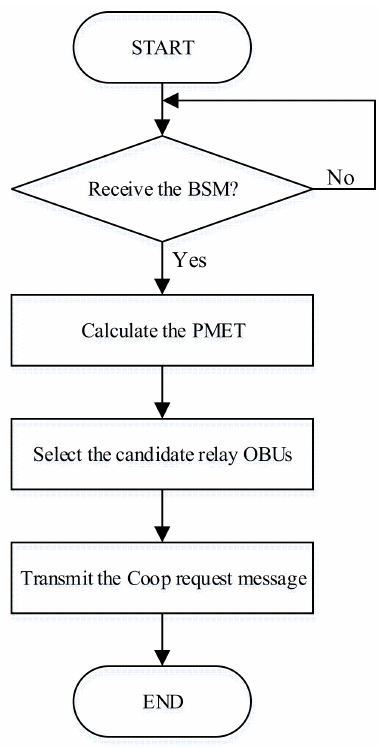
Figure 2. The flowchart of the on-board unit (OBU) that does not transmit a WAVE service advertisement (WSA) message.